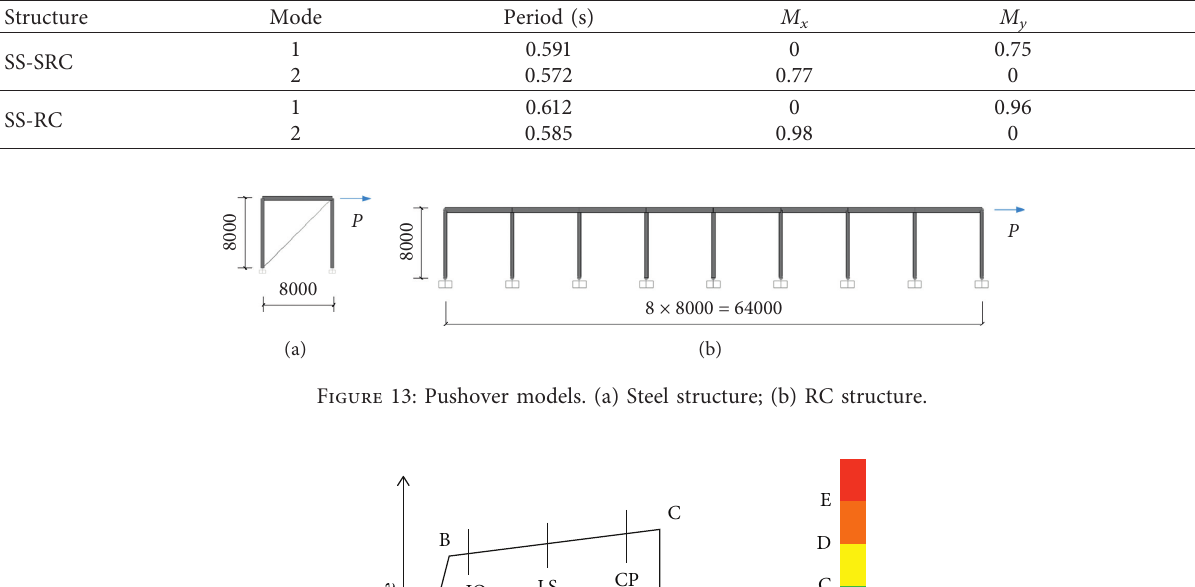
Table 3: The first two modal participating mass ratios.